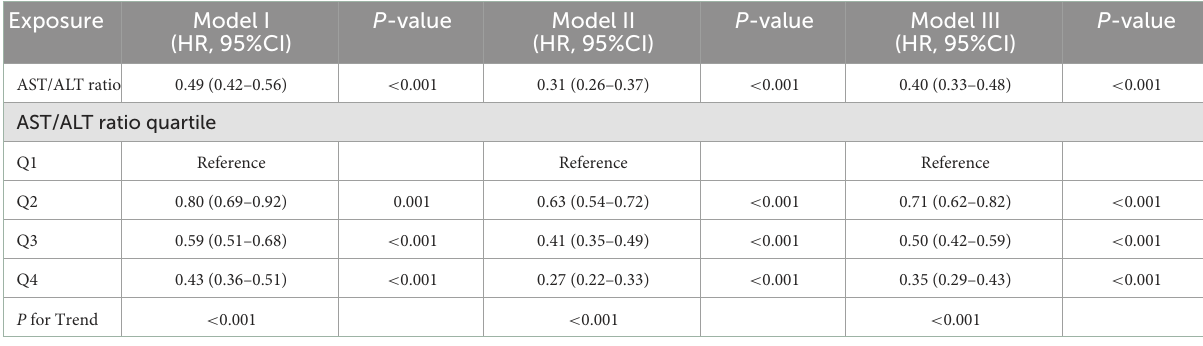
TABLE 4 Relationship between AST/ALT ratio and the risk of diabetes in prediabetic patients in different models. Exposure